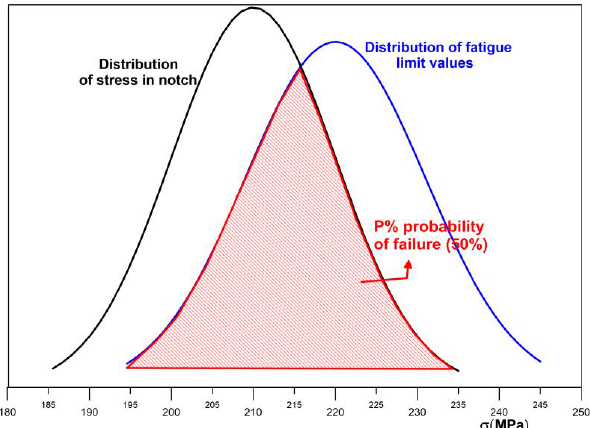
Figure 11. Statistical interpretation of the risk of early fatigue fracture for a critical location at the point of the internal thread in the guide bar of the press machine.